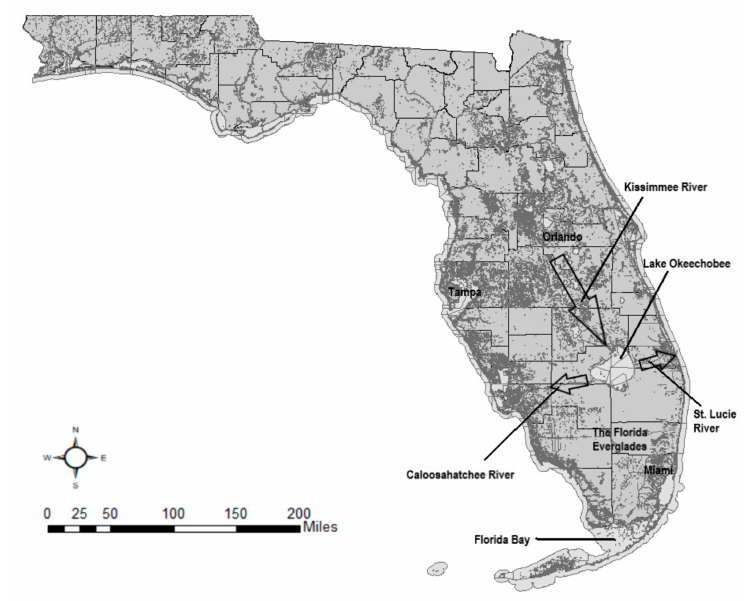
Figure 1. Map of Florida showing current water flow into and out of Lake Okeechobee. The locations of the densely populated cities of Orlando, Tampa, and Miami are noted, as well as the locations of the Kissimmee River, Lake Okeechobee, the Caloosahatchee River, the St. Lucie River, the Florida Everglades, and Florida Bay. Arrows show the current direction of water flow impacting the study region, which begins in the Orlando area in Central Florida and flows south into Lake Okeechobee. Prior to construction of Florida’s system of water control structures and canals, water would flow south from Lake Okeechobee into the Florida Everglades, and continue flowing in a southward direction into Florida Bay. After construction of the water control system, water instead flows west to the Caloosahatchee River, and east to the St. Lucie River.